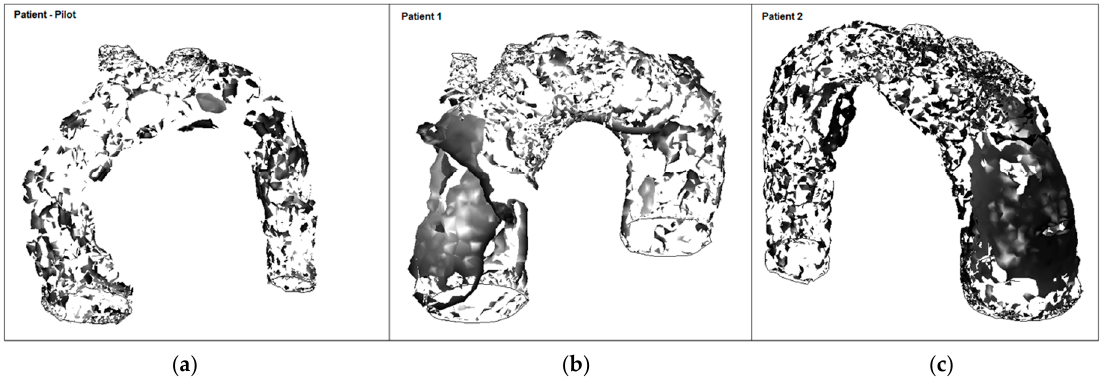
Figure 18. Formation of vortical structures (at peak systole): ( a ) Patient-pilot; ( b ) Patient 1; ( c ) Patient 2. In patient-pilot, the VSs break up into smaller substructures at peak systole. In contrast to the TAA cases, streamwise VSs are reinforced at the beginning, coinciding to low WSS.